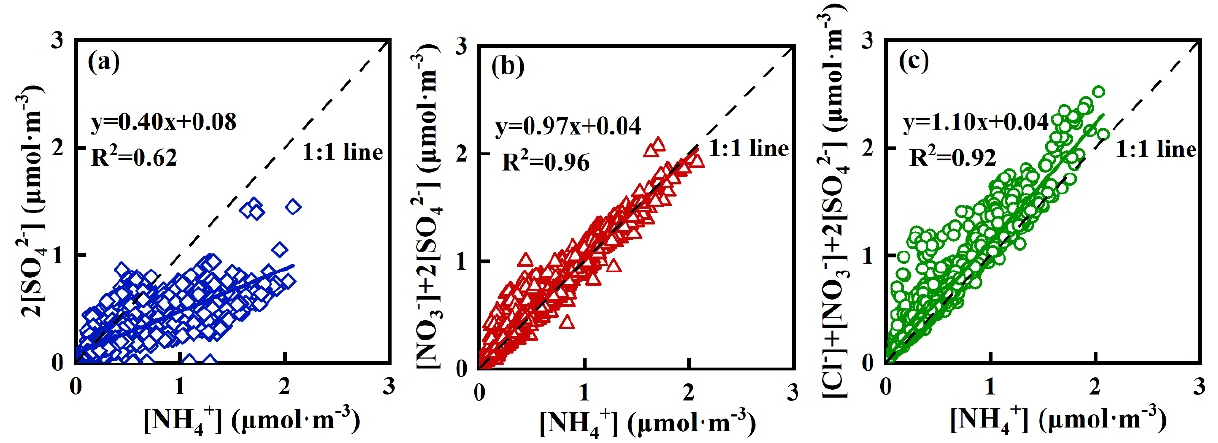
Figure 6. ( a – c ) Scatter plots of ammonium and acidic ions for PM 2.5 .